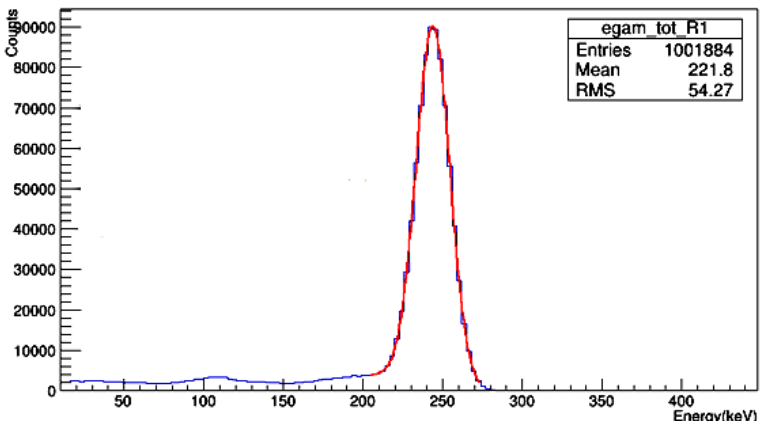
Figure 3. The simulated spectrum at 0.245 MeV using Geant4 code, where the blue spectrum is the original spectrum and the red spectrum due to the Gaussian fitted spectrum.